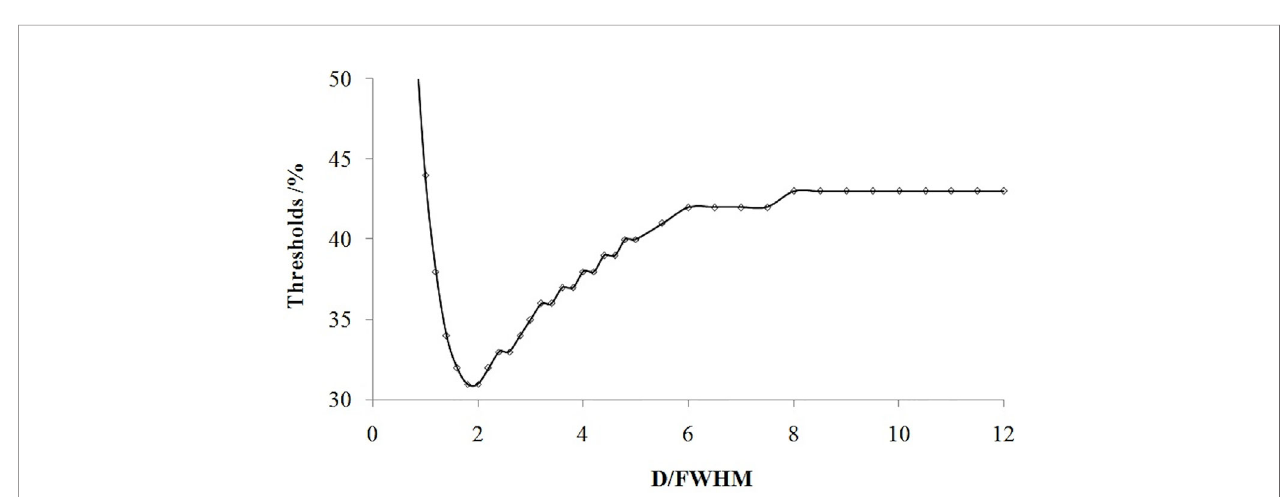
FIGURE 4 | Relationship of the threshold and ratio of the tumor diameter (D) with the spatial resolution (FWHM).